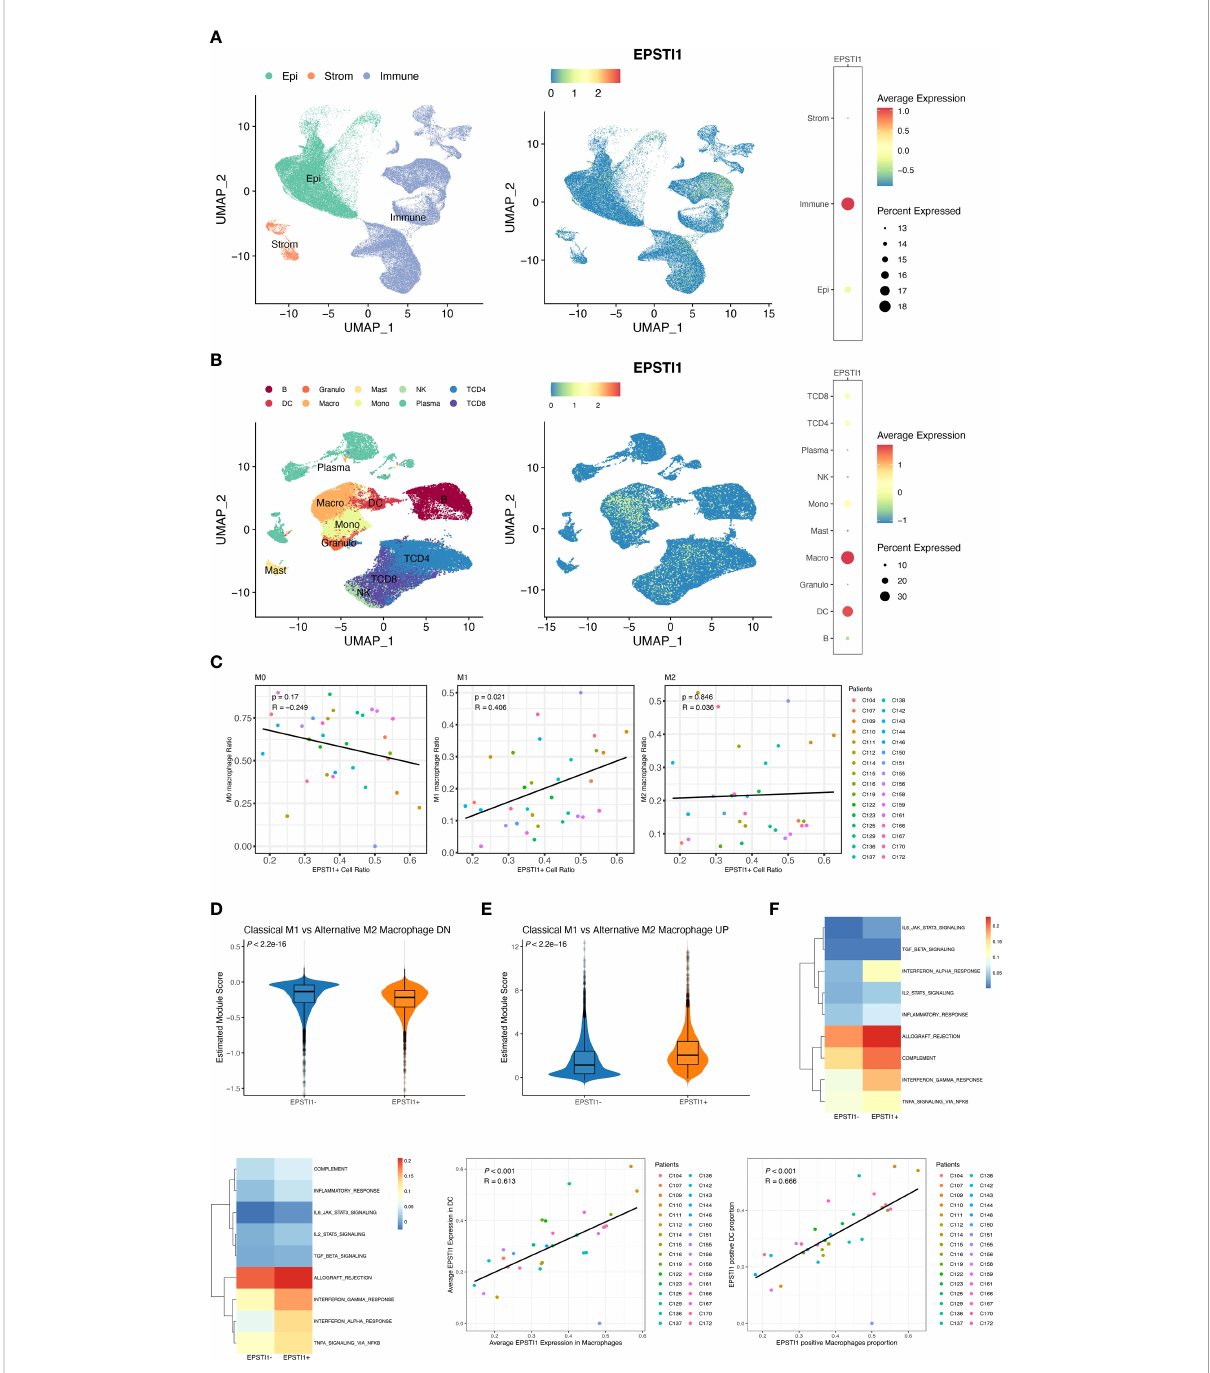
FIGURE 6 The analysis of EPSTI1 expression at the single cell level. (A, B) EPSTI1 expression levels in various cell types revealed by dimensional reduction plots (left and middle panels) and dot plots (right panels). The results show that EPSTI1 is mainly expressed in immune cells, especially in macrophages and dendritic cells. Epi, epithelial cells; Strom, stromal cells; B, B cells; Granulo, granulocytes; Mast, mast cells; NK, natural killer cells; TCD4, CD4 positive T cells; TCD8, CD8 positive T cells; DC, dendritic cells; Macro, macrophages; Mono, monocytes; Plasma, plasma cells. (C) The EPSTI1+ macrophage ratio and M1 macrophage ratio are signi fi cantly correlated (R = 0.406, P = 0.021) (D, E) The module scores of gene signatures related to M1/M2 polarization in EPSTI1+/- macrophages suggest that EPSTI1+ macrophages have more M1 features. (F) Mean pathway activity scores of EPSTI1+/- macrophages. The immune-related pathways appear to be more active in EPSTI1+ macrophages. (G) Mean pathway activity scores of EPSTI1+/- DCs. Immune-related pathways are scored higher in EPSTI1+ DCs. (H, I) Macrophages and DCs are signi fi cantly correlated (R > 0.60, P < 0.001) in terms of EPSTI1 expression levels and the proportion of EPSTI1 positive